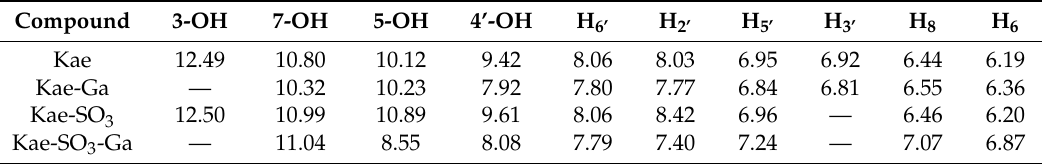
Table 2. Chemical shifts of hydrogen atoms in 1 H NMR spectra for Kae, Kae-Ga, Kae-SO 3 and Kae-SO 3 -Ga, respectively.